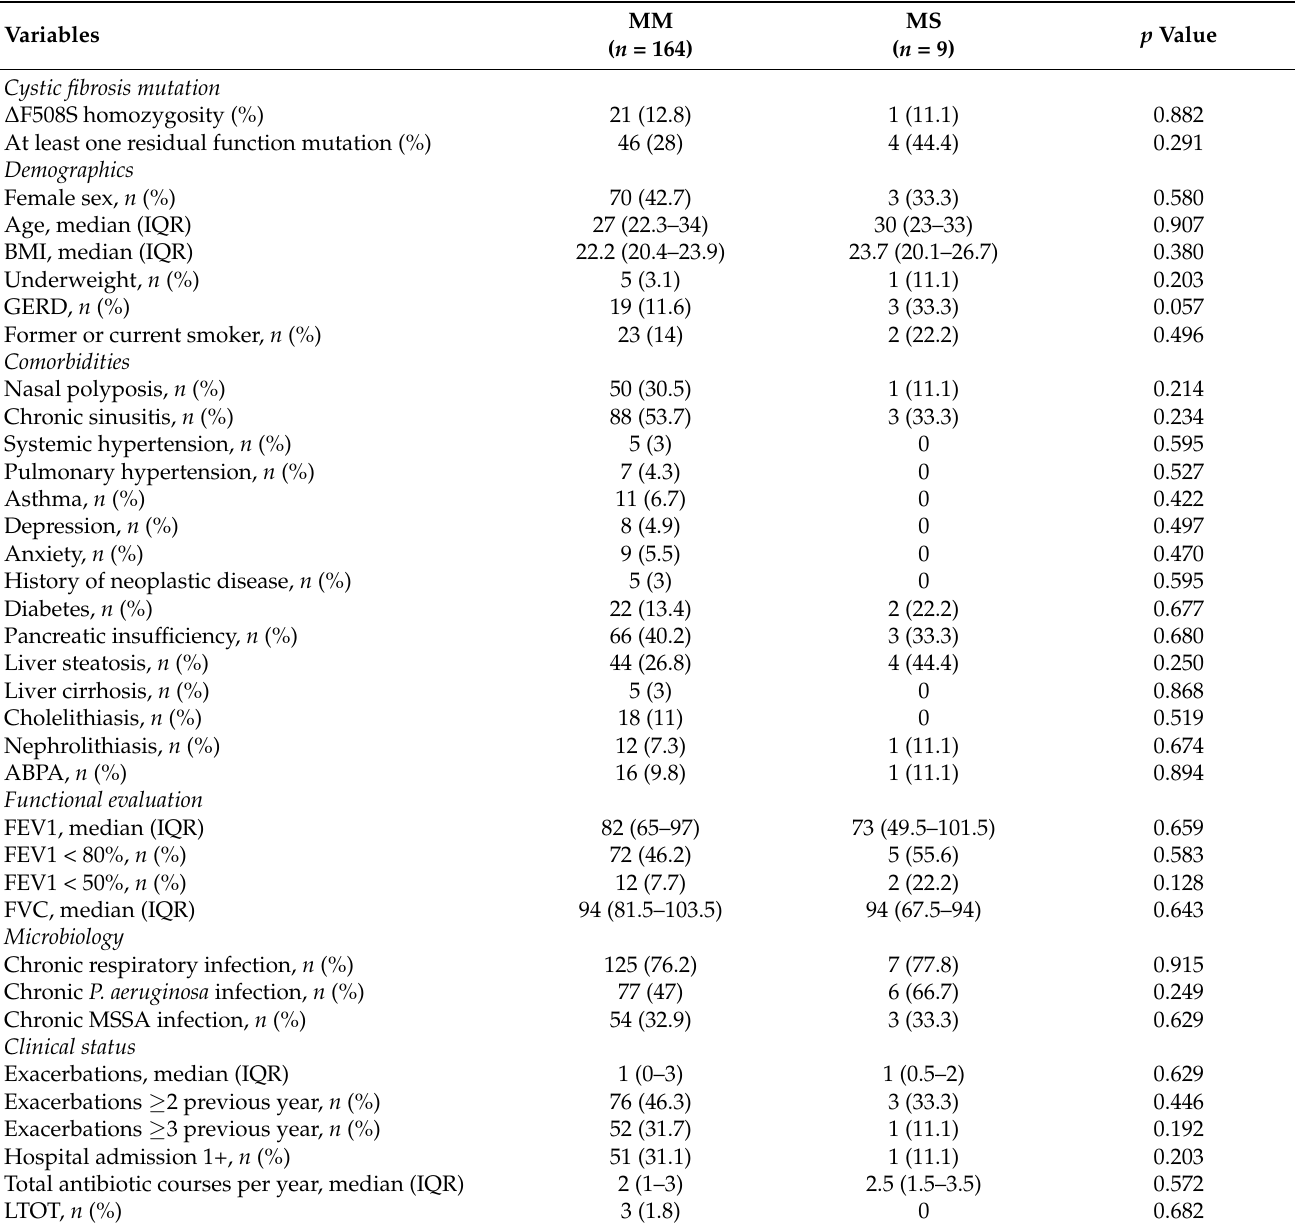
Table 2. Comparison of demographics and clinical, functional and microbiological characteristics of the two study